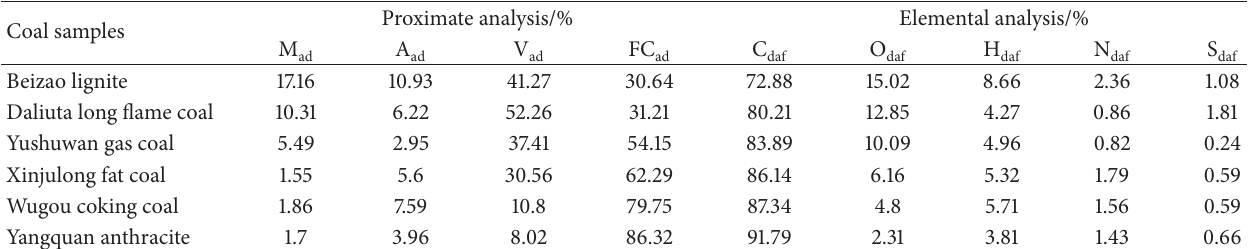
Table 1: Proximate analysis and elemental analysis of coal samples of different types. Proximate analysis/% Elemental Coal samples